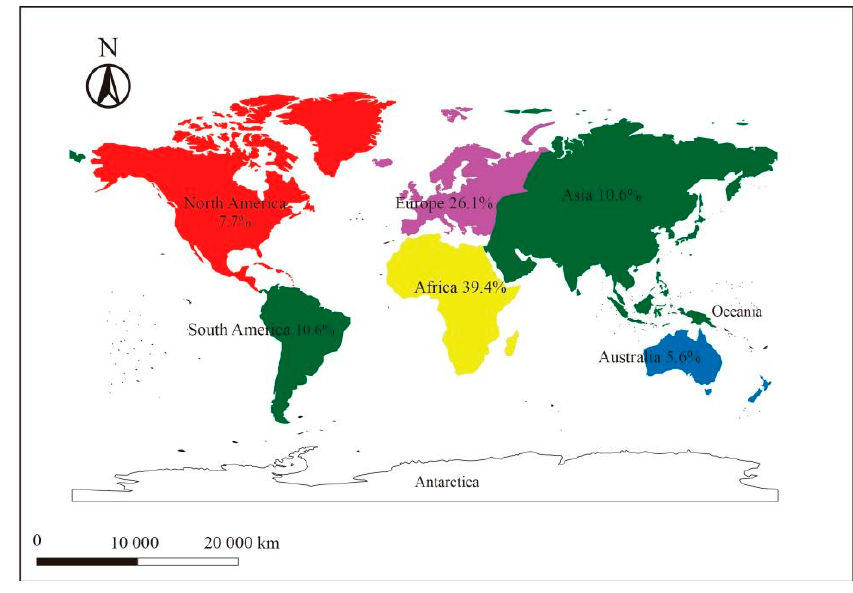
Figure 2. Continental percentage distribution of online survey respondents.